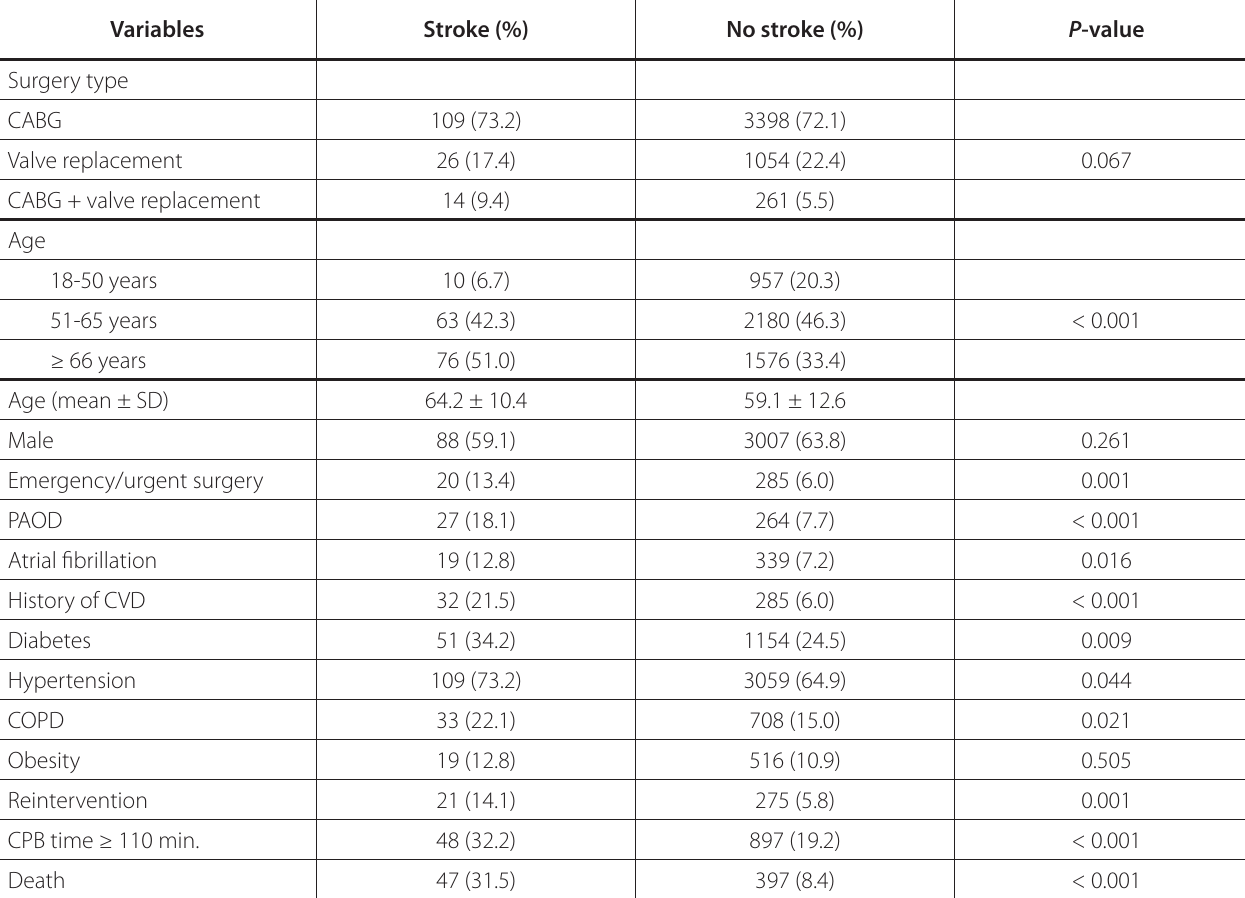
Table 1 . Univariate analysis of study groups